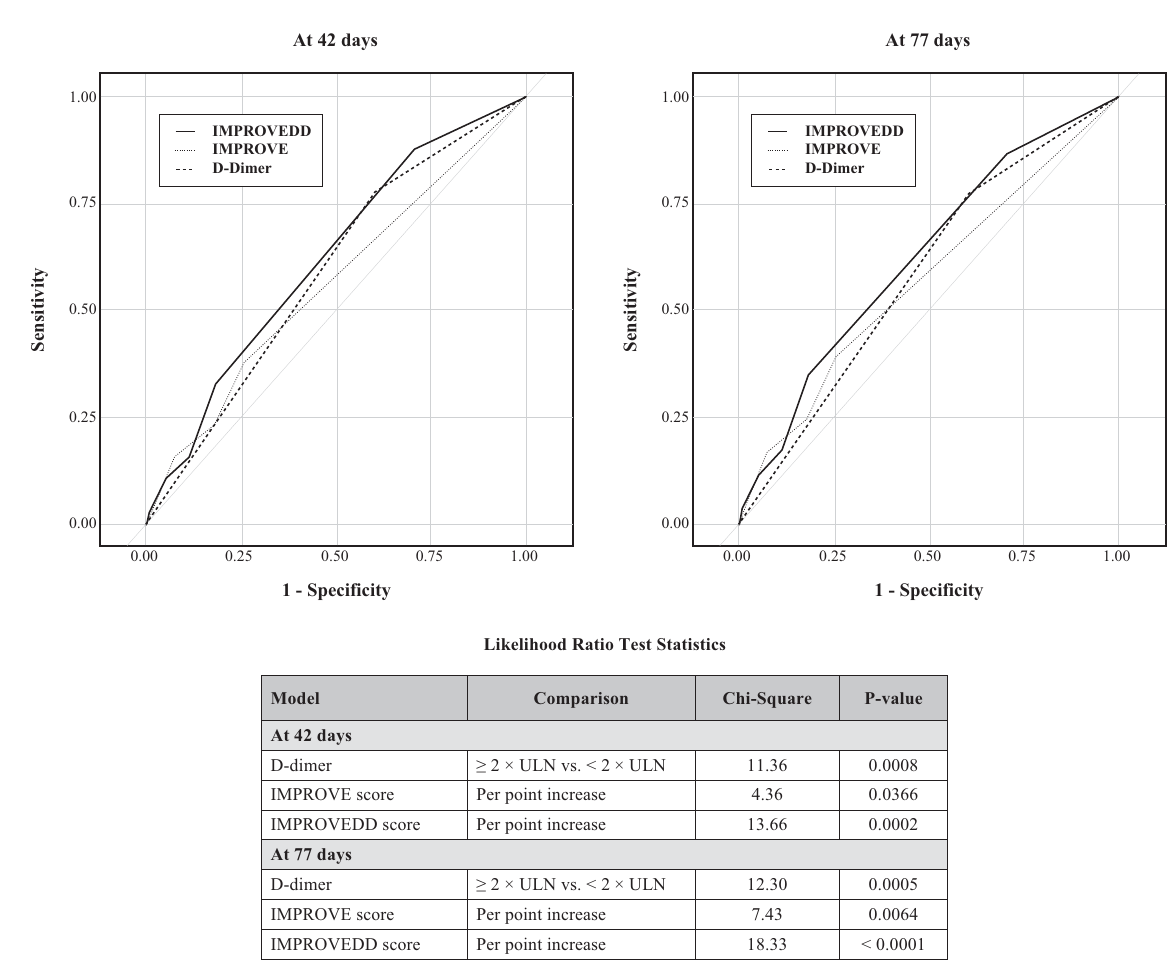
Fig. 2 Receiver – operating – characteristic (ROC) curves for D-dimer, IMPROVE, and IMPROVEDD models in predicting symptomatic VTE.